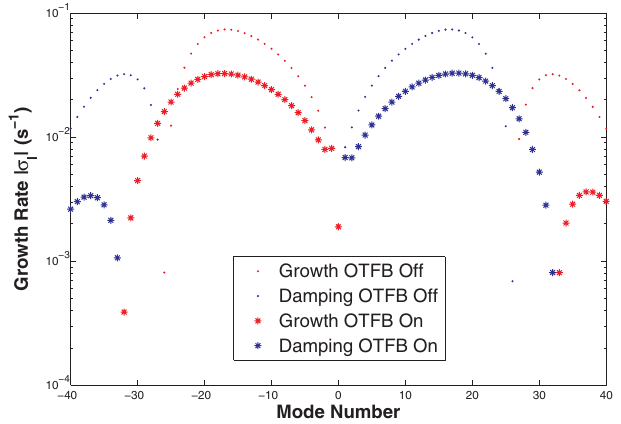
FIG. 7. (Color) Modal growth rates for configuration injection end 0.3 A with 1-Turn feedback (OTFB) on or off.